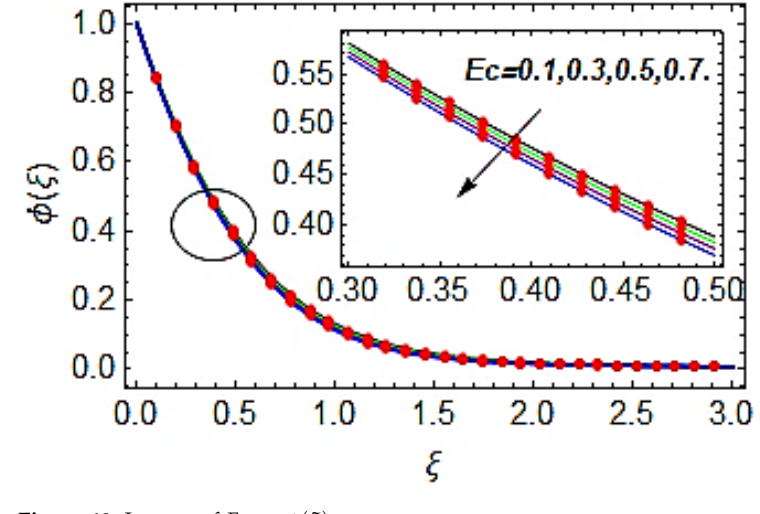
Figure 13. Impact of Ec on φ ( ξ ) .